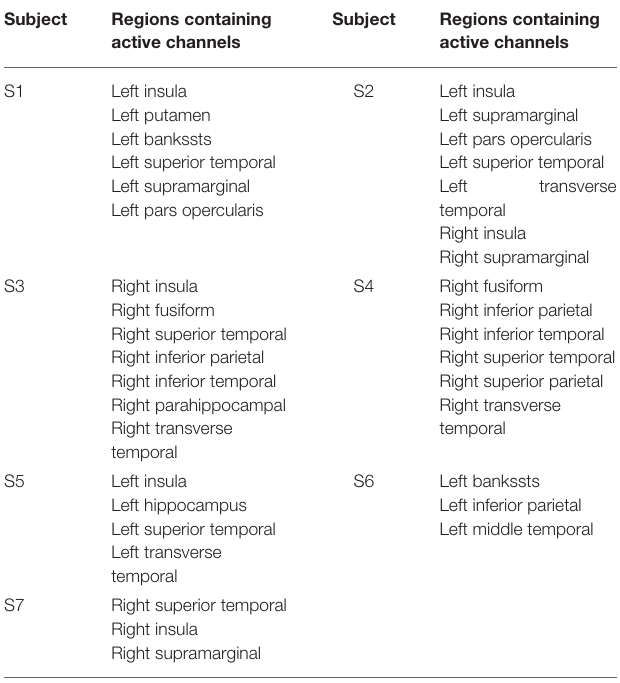
TABLE 2 | Regions containing active channels used for